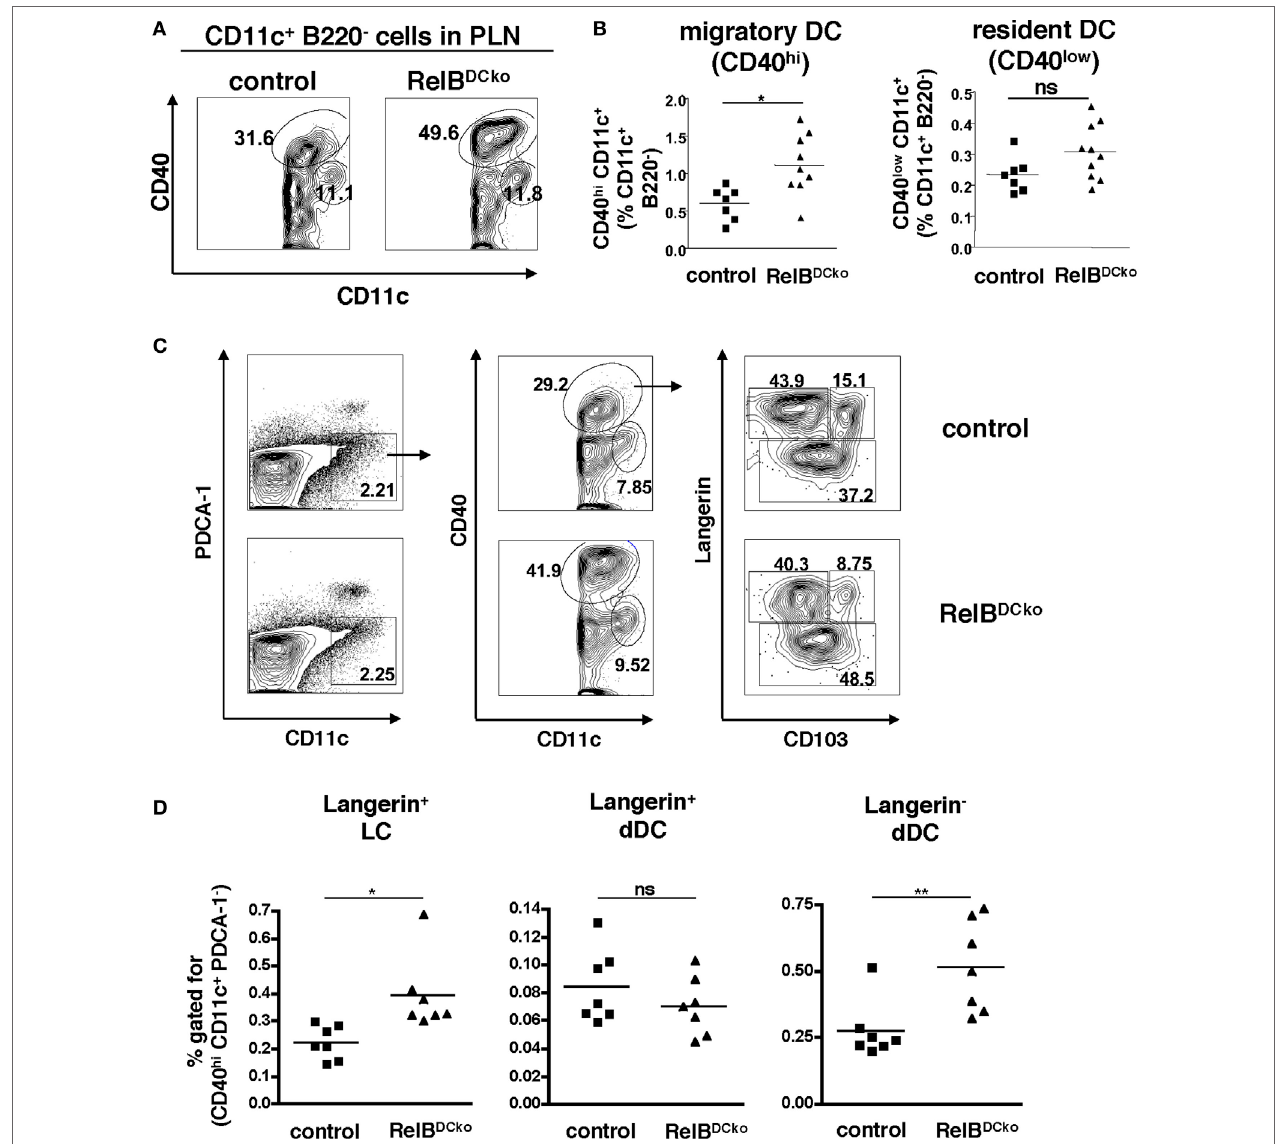
FigUre 1 | RelB DCko mice show an increased frequency of Langerhans cells (LCs) and Langerin − dermal DCs (dDCs) among steady-state migratory DCs in skin-draining lymph nodes. (a,B) Cells from peripheral LN (PLN) of control and RelB DCko mice were stained for B220, CD11c, and CD40 and analyzed by flow cytometry. (a) Contour plots represent CD11c + B220 − cells within a FSC/SSC gate for live cells. Based on the expression of CD40 migratory CD40 hi dendritic cell (DC) and resident CD40 low DC are distinguished among CD11c + B220 − cells. B220 − CD11c low CD40 low cells represent RelB − macrophages. Numbers indicate the percentages of cells within the gate. (B) Statistical summary of frequencies of migratory and resident DC among CD11c + B220 − cells PLN of RelB DCko ( n = 11) or control mice ( n = 7). Percentages of both DC subsets among CD11c + B220 − cells were calculated in relation to the absolute frequency of CD11c + B220 − cells. Each symbol represents an individual mouse and black lines indicate the mean values. Statistical analyses were performed using the Mann–Whitney Test: ns, not significant, * p < 0.05. (c) Representative flow cytometric analysis of migratory DC subpopulation in PLN of control and RelB DCko mice after surface staining of CD11c, CD40, and CD103 and intracellular staining of Langerin. After gating specifically on CD11c + B220 − cells (right panel), migratory CD40 hi DCs (middle panel) were further analyzed for their expression of Langerin versus CD103. Three migratory DC subsets could be defined: Langerin + CD103 − LC, Langerin + CD103 + dDC, and Langerin − CD103 + / − dDC (left panel). Numbers indicate the percentages of cells within each gate. (D) Frequencies of Langerin + CD103 − LC, Langerin + CD103